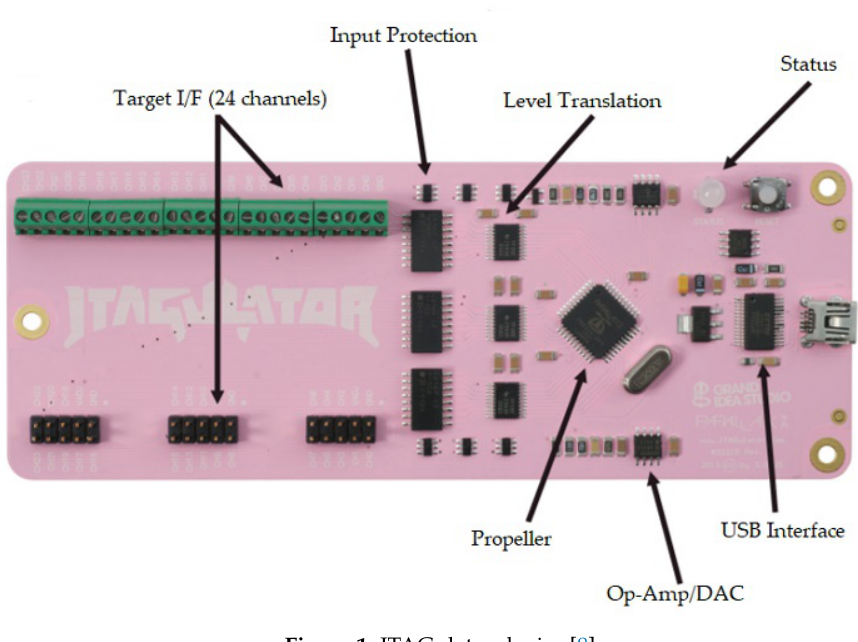
Figure 1. JTAGulator device